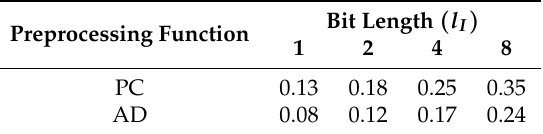
Table 3. Theoretical correlation coefficients of Equation (2) for preprocessing functions and the bit length of intermediate values when the length of the register is